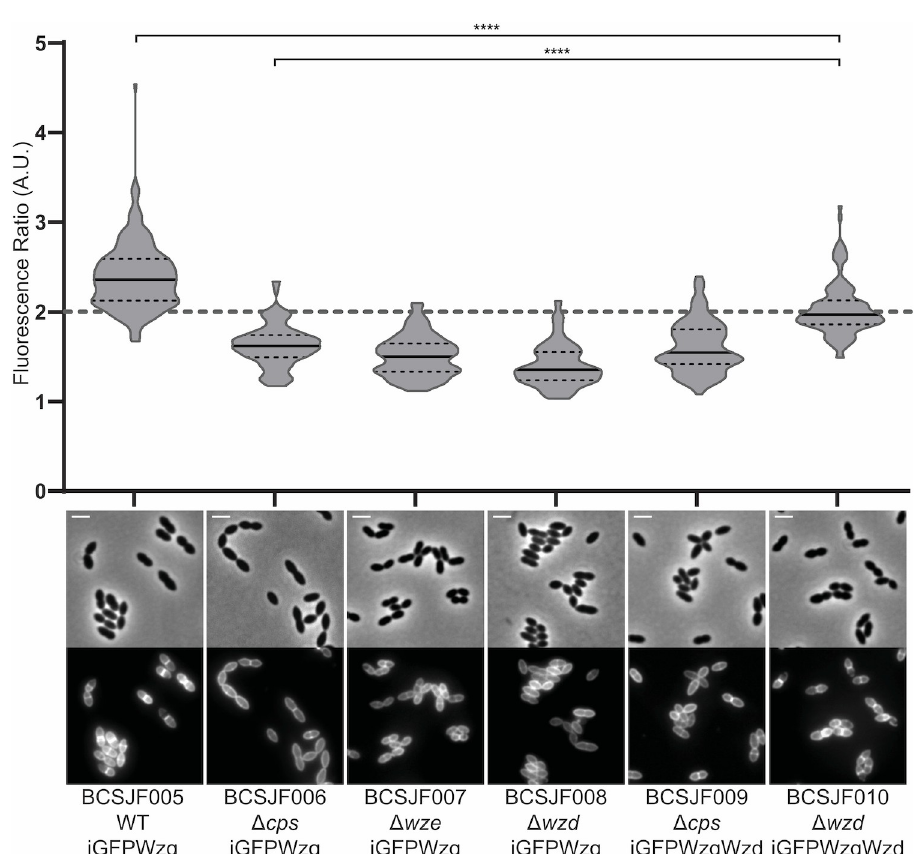
Fig 2. Septal localization of Wzg is dependent on the expression of Wzd/Wze. Graph shows the ratio of iGFP-Wzg fluorescence measured at the septum versus the peripheral wall in the S . pneumoniae wild-type encapsulated strain (BCSJF005, n = 194), in the cps null mutant (BCSJF006, n = 121), in the wze null mutant (BCSJF007, n = 106), in the wzd null mutant (BCSJF008, n = 107) and in the cps and wzd null mutants expressing Wzd from a constitutive promoter (BCSJF009, n = 112, and BCSJF010, n = 109, respectively). Enrichment of Wzg at the septum is only observed when Wzd is expressed and is localized at the division septum. Solid lines indicate median, and dashed lines indicate 25% and 75% percentiles. Representative phase contrast and fluorescence microscopy images of each strain are shown below the graph. ���� P � 0.0001. Scale bar, 2 μ